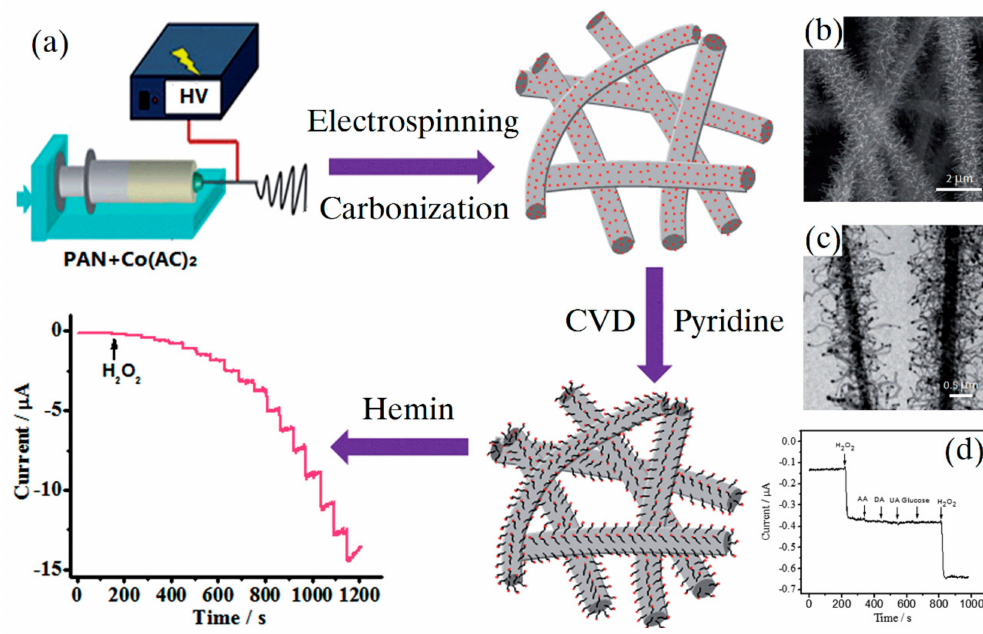
Figure 5. ( a ) Schematic presentation of the fabrication of NCNT / CNFs composite; ( b ) SEM images of the NCNT / CNF composite; ( c ) TEM images of the NCNT / CNF composite; ( d ) selectivity of the NCNT / CNF composite. (Reproduced with permission from [60]).